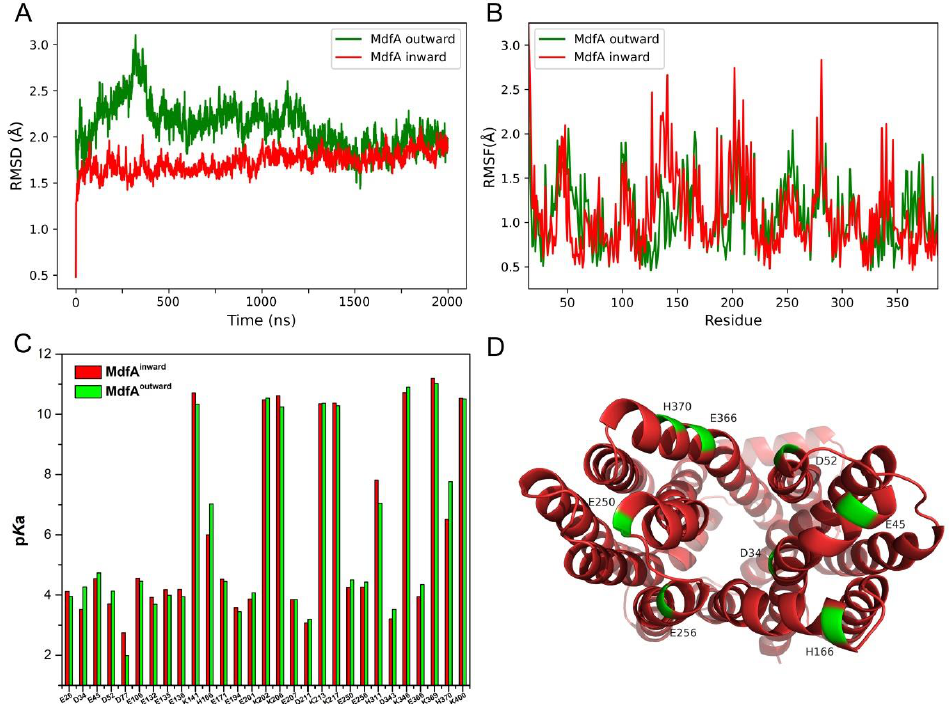
Figure 4. Flexibilities and p K a values of MdfA. ( A ): Backbone RMSD of MdfA inward and MdfA outward . ( B ): RMSFs of MdfA inward and MdfA outward . ( C ): p K a values of each residue of MdfA inward and MdfA outward . ( D ): Periplasmic view of the residues that had higher p K a values at outward-facing conformation.